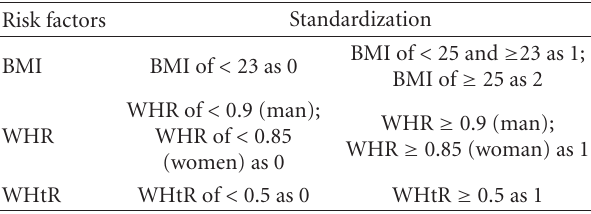
Table 5: Risk factors and standardization of risk